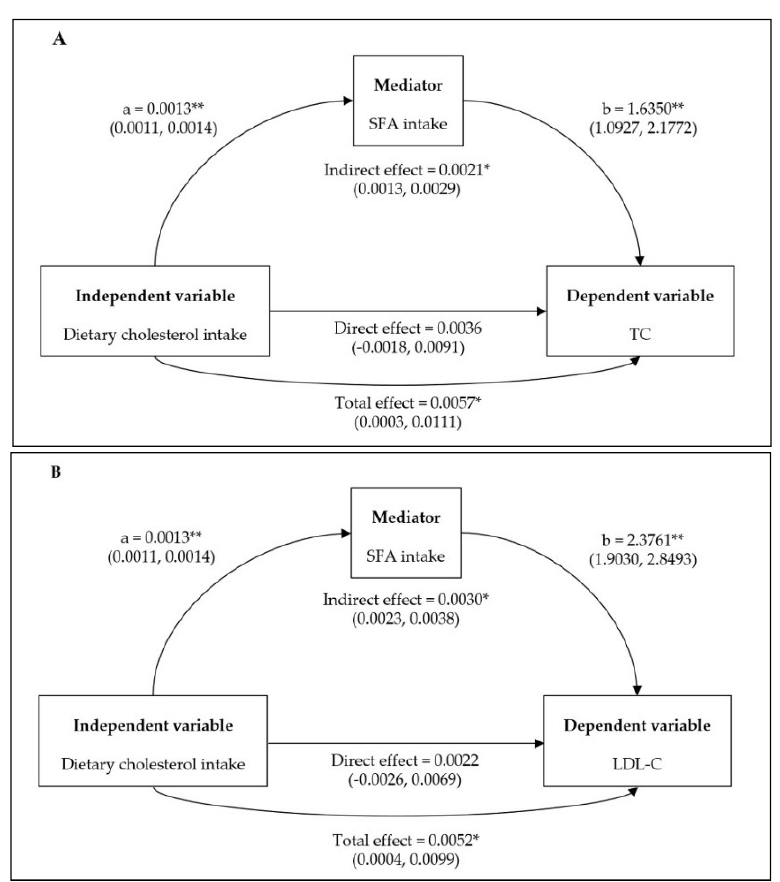
Figure 1. Mediation effects of saturated fatty acid (SFA) on the association between dietary cholesterol and serum levels of total cholesterol (TC; A ), and low-density lipoprotein-cholesterol (LDL-C; B ). Confounding factors were age, sex, BMI, physical activity, educational level, drinking, carbohydrate, and protein. Unstandardized coefficients were shown along with their estimated p values: “a” is the linear regression coefficient of the dietary cholesterol–SFA association; “b” is the linear regression coefficient of the SFA–serum levels of TC and LDL-C. * p < 0.05; ** p < 0.001. Consumption of processed meat was positively associated with the risk for abnormalities in both TC and LDL-C levels after adjustment for all potential confounders (Tables 3 and 4). The risk for